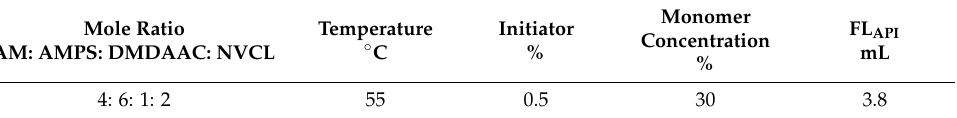
Table 2. Optimal synthesis conditions and performance of